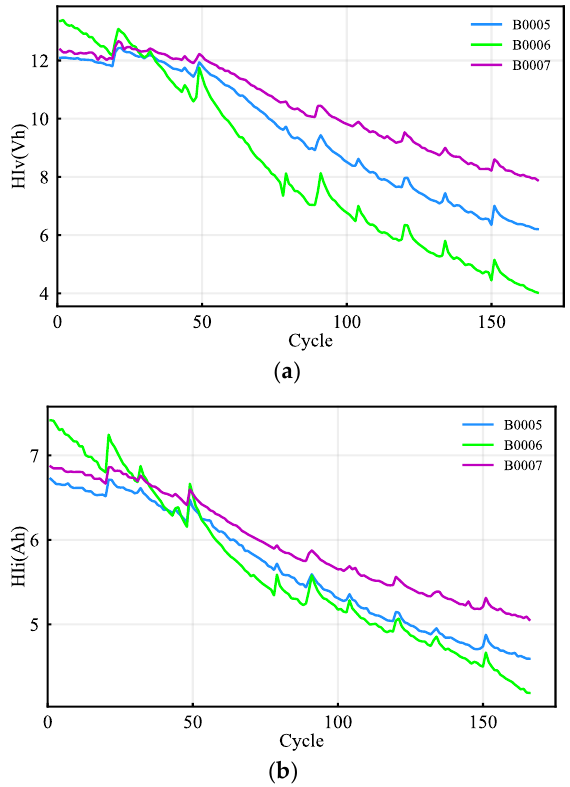
Figure 4. ( a ) The values of the HI v versus the cycle number; ( b ) the values of the HI i versus the cycle number.